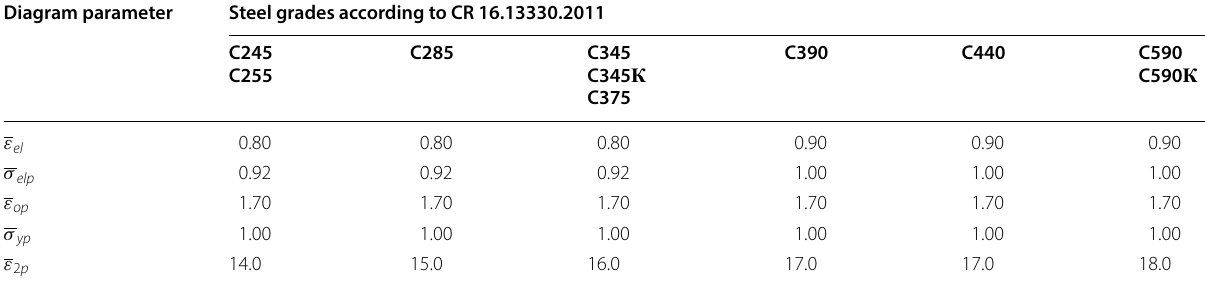
Table 1 Coordinates of diagram characteristic points of the steel shell deformation. Diagram